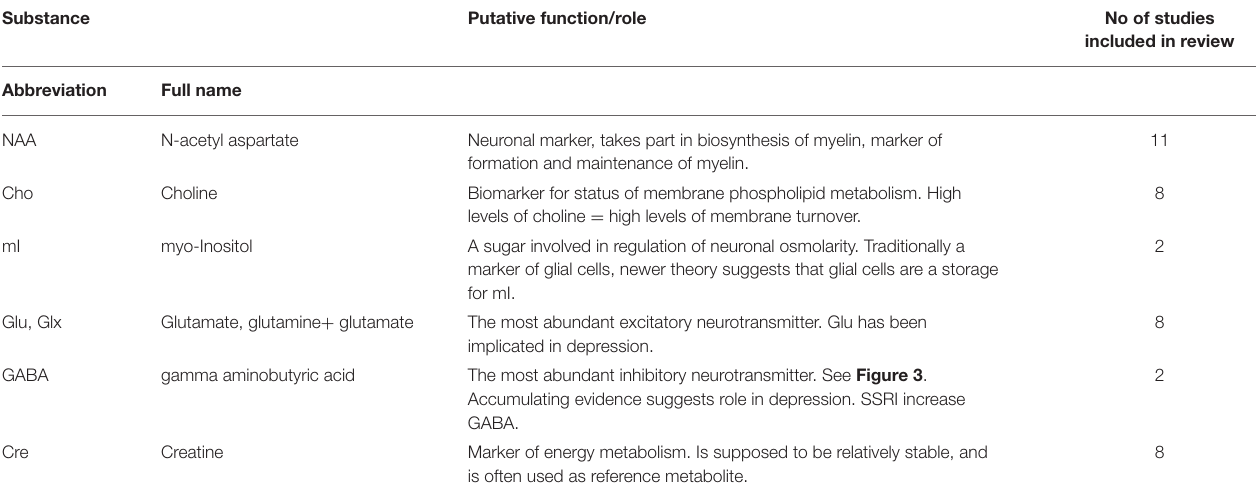
TABLE 2 | An overview of names, and supposed role/function of the most common substances investigated in this report. Substance